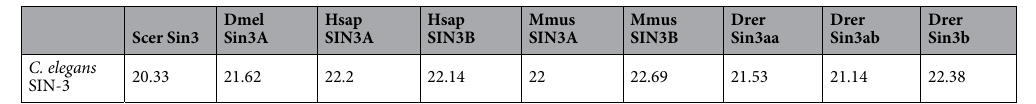
Table 1. Percentage sequence identity of C. elegans SIN-3 protein with the SIN3 isoforms in other model organisms (Hsap, Homo sapiens ; Mmus, Mus musculus ; Drer, Danio rerio ; Dmel, Drosophila melanogaster ; Scer, Saccharomyces cerevisiae